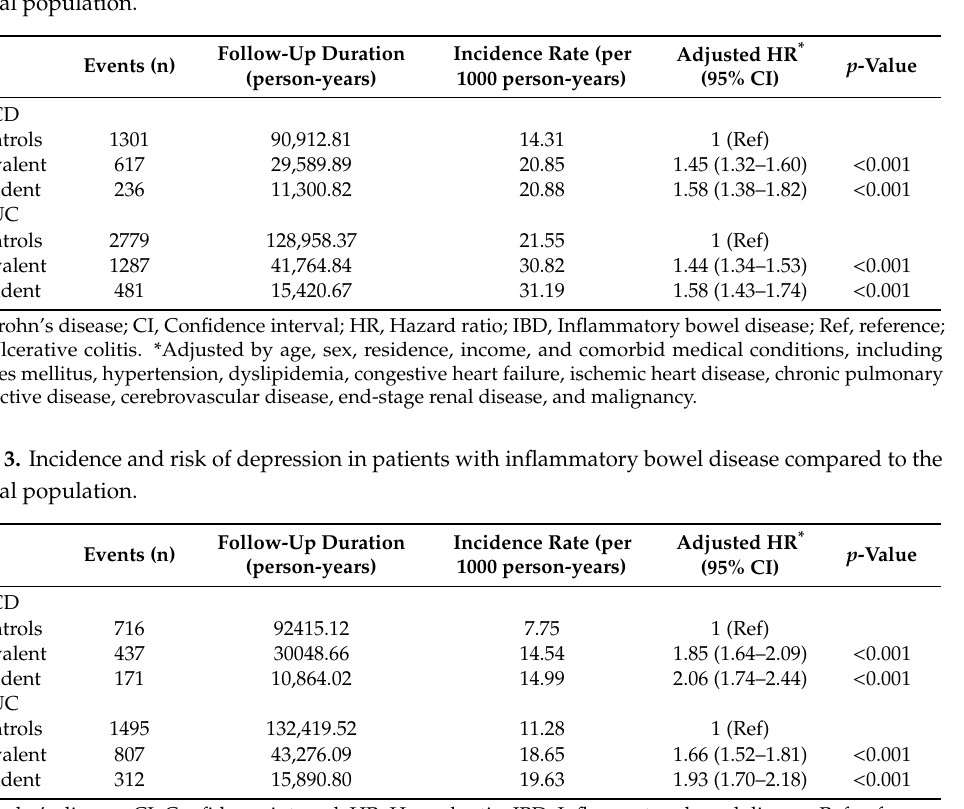
Table 2. Incidence and risk of anxiety in patients with inflammatory bowel disease compared to the general population.